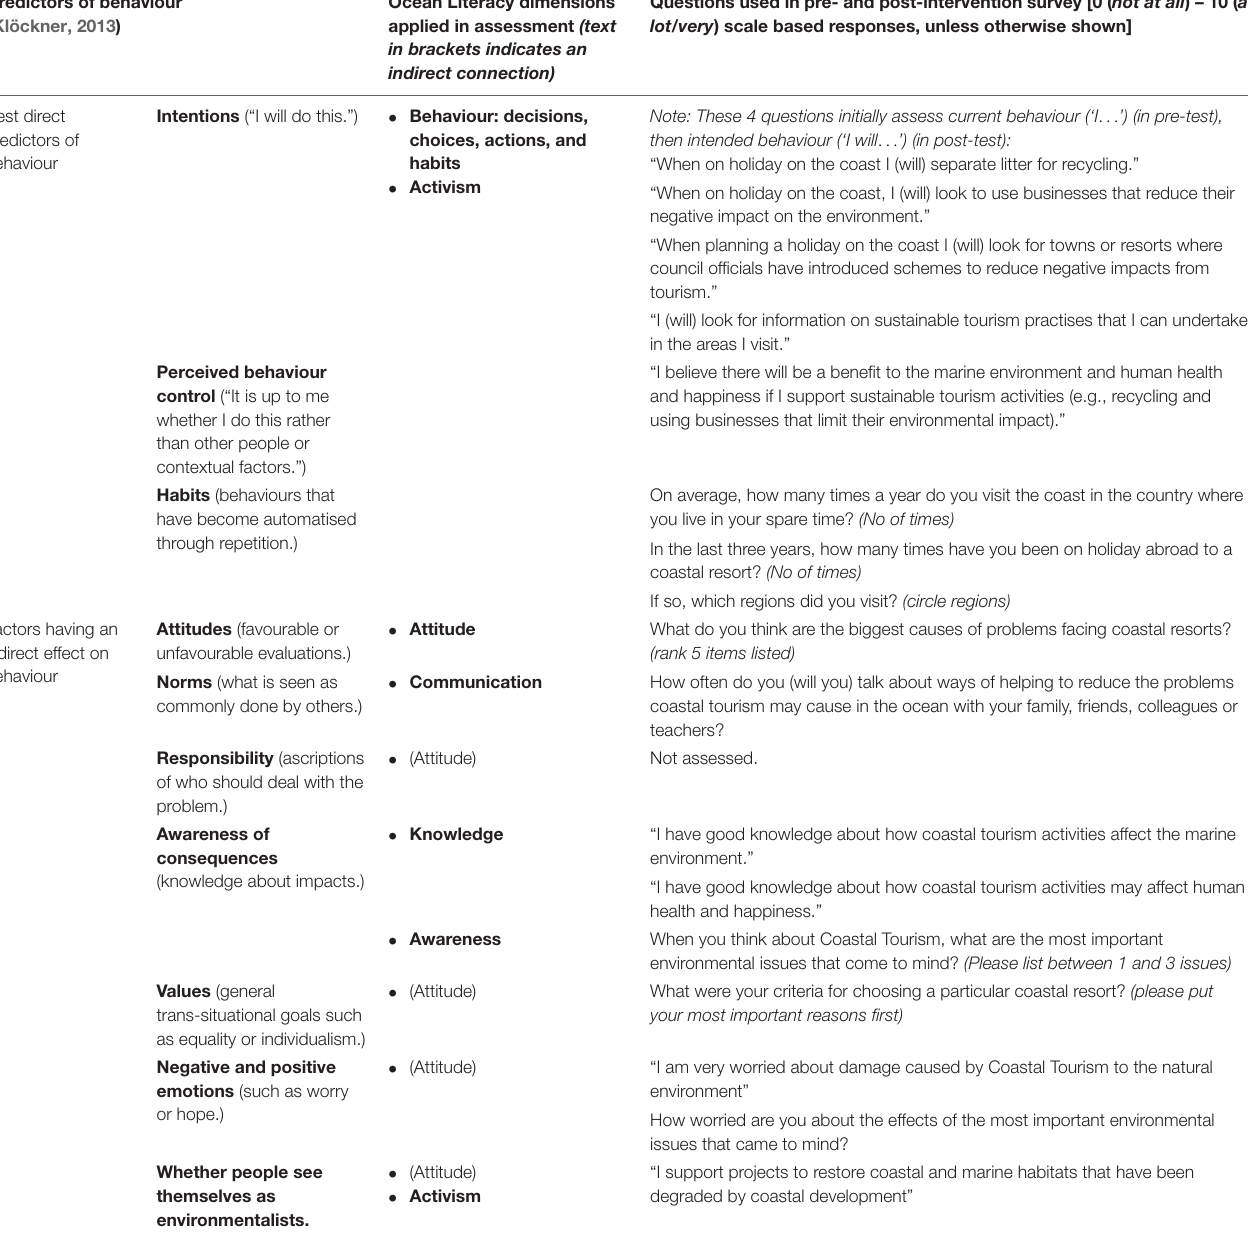
TABLE 3 | Relationship between questions developed to assess effectiveness of the Ocean Literacy tool, predictors of behaviour and Ocean Literacy dimensions assessed. Predictors of behaviour (Klöckner, 2013)